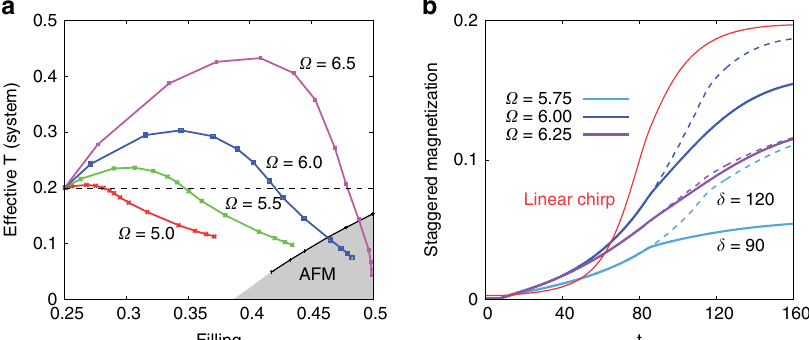
Fig. 3 Photo-doping induced antiferromagnetic order in the fi rst set-up. Panel a Effective system temperature after the pulse as a function of fi lling. The dashed line shows the temperature ( T ¼ 0 : 2) of the initial quarter- fi lled state. Different curves correspond to different (but fi xed) pulse frequencies Ω , ¼ 0 : 8). The black line shows the Néel temperature in equilibrium. Panel b Time while different points correspond to different pulse durations δ ( a max ¼ 0 : 8 and indicated Ω in the presence of a dependence of the staggered magnetization for pulses with δ ¼ 90 (solid lines) and 120 (dashed), a max staggered magnetic fi eld h ¼ 0 : 001. (The red curve in panel b shows the result for the second set-up and a chirped pulse with parameters δ ¼ 90, a ¼ 0 : 1625, Ω ¼ 6 : 6 and Ω ¼ 7 : max in fin